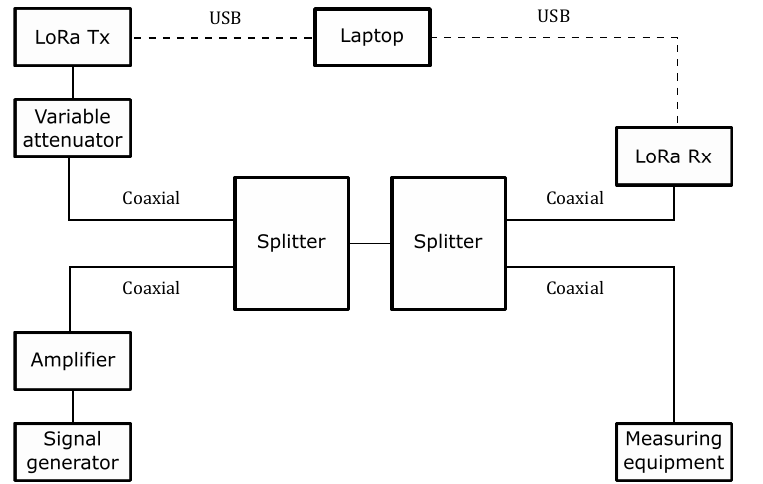
Figure 7. A block diagram representation of the test